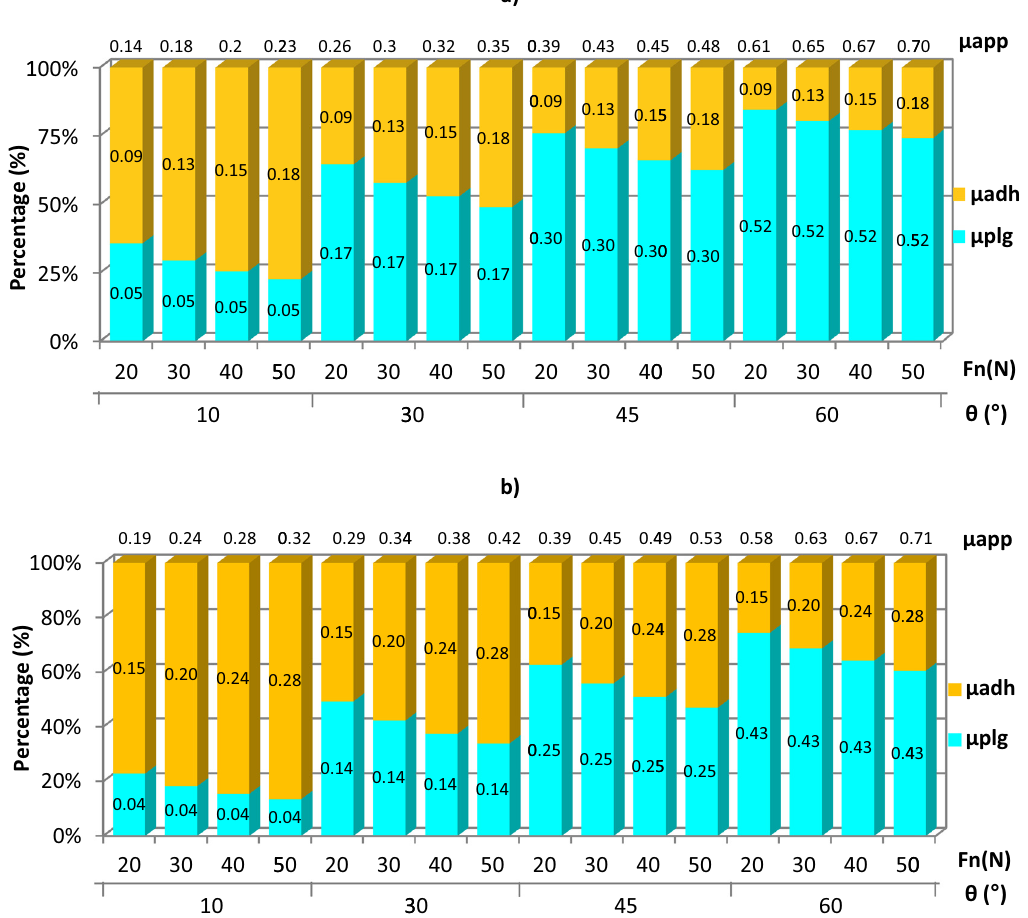
Figure 7: Proportion percentage of ploughing and adhesive component of the predicted apparent friction coe ffi cient as a function of attack angle and normal load ( a ) SST // and ( b ) SST ⊥